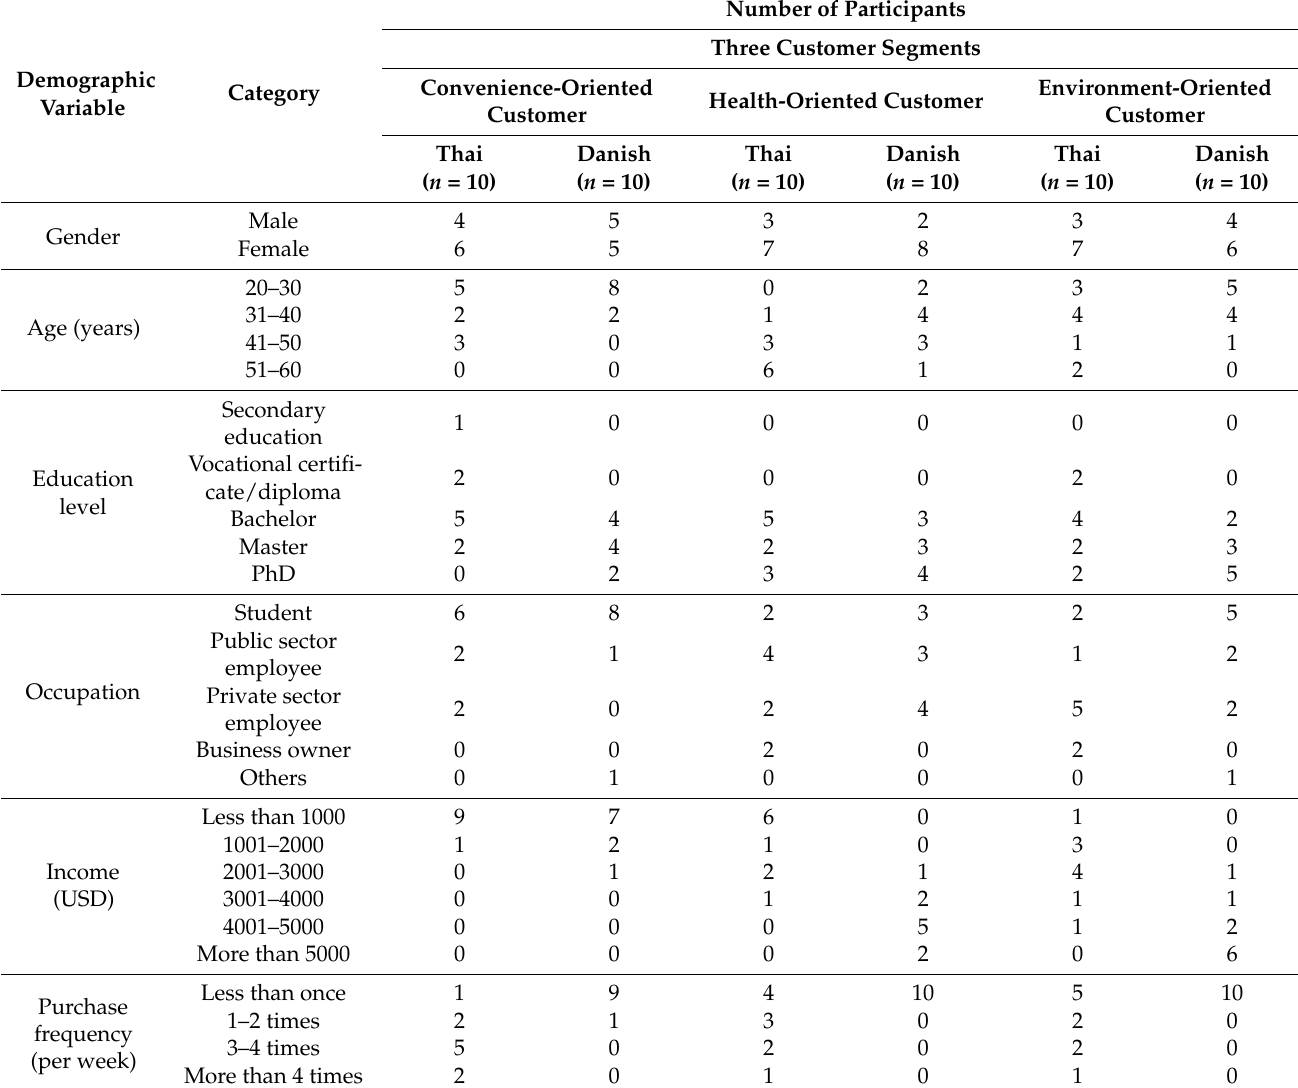
Table 2. Demographic Profiles of Interview Participants ( n =